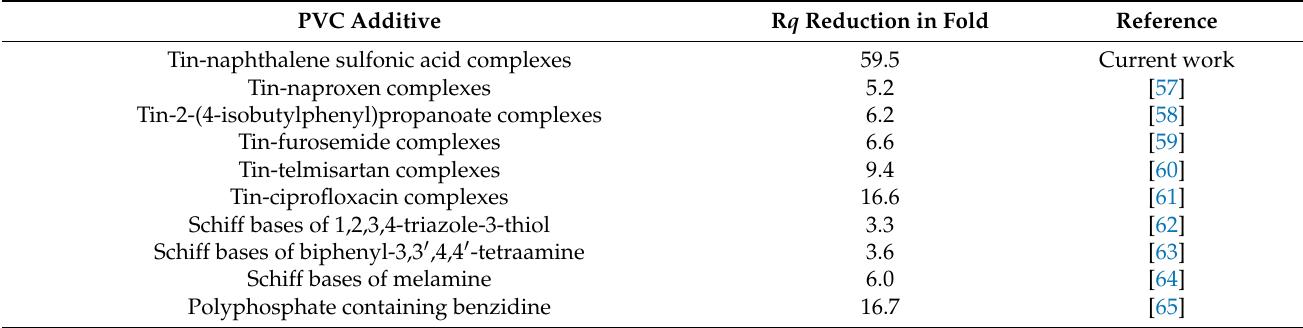
Figure 11. AFM images of irradiated PVC films. Table 4. The effect of various additives on the R q of PVC films.